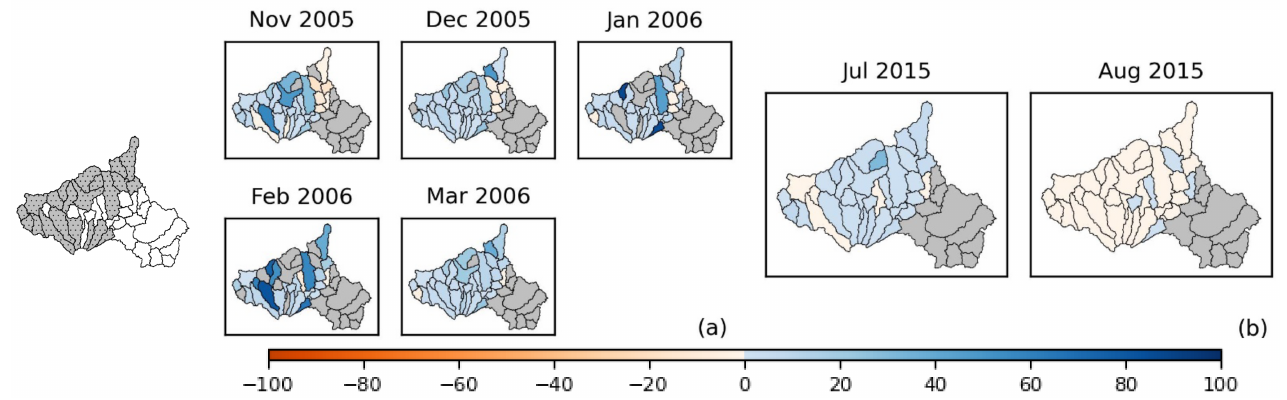
Figure 11. Drought severity change in percentage in the subbasins where the measure is applied and in downstream subbasins: hydrological drought event I ( a ) and hydrological drought event III ( b ). The location of the measure is presented on the left side of the